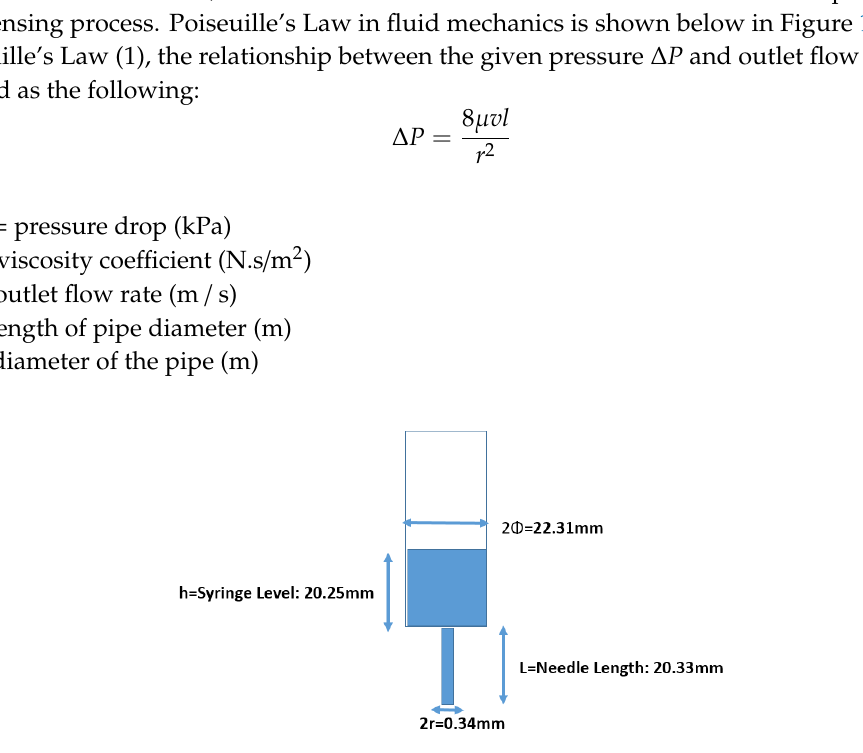
Figure 1. Needle extrusion structure.